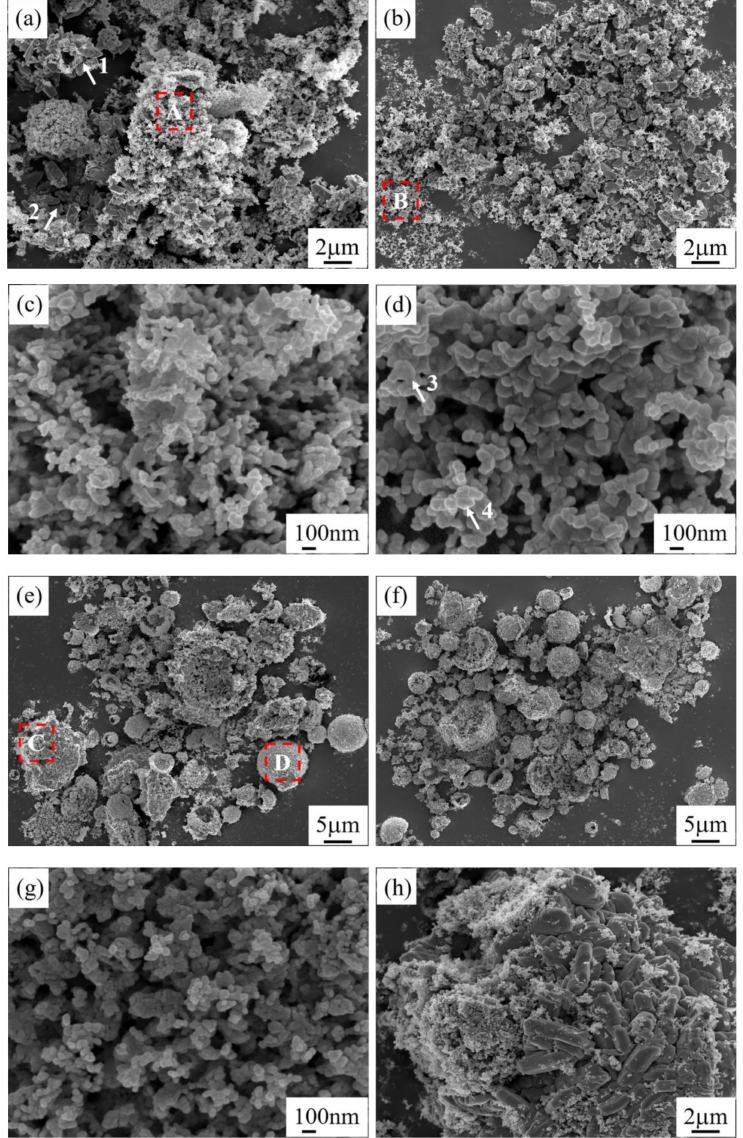
Figure 12. SEM images of Cu-10 wt%W and Cu-30 wt%W precursor powders calcined at 500 ◦ C and 600 ◦ C: ( a ) Cu-10 wt%W, 500 ◦ C; ( b ) Cu-10 wt%W, 600 ◦ C; ( c ) larger version of area A in Figure 12a; ( d ) larger version of area B in Figure 12b; ( e ) Cu-30 wt%W, 500 ◦ C; ( f ) Cu-30 wt%W, 600 ◦ C; ( g ) larger version of area C in Figure 12e; ( h ) larger version of area D in Figure